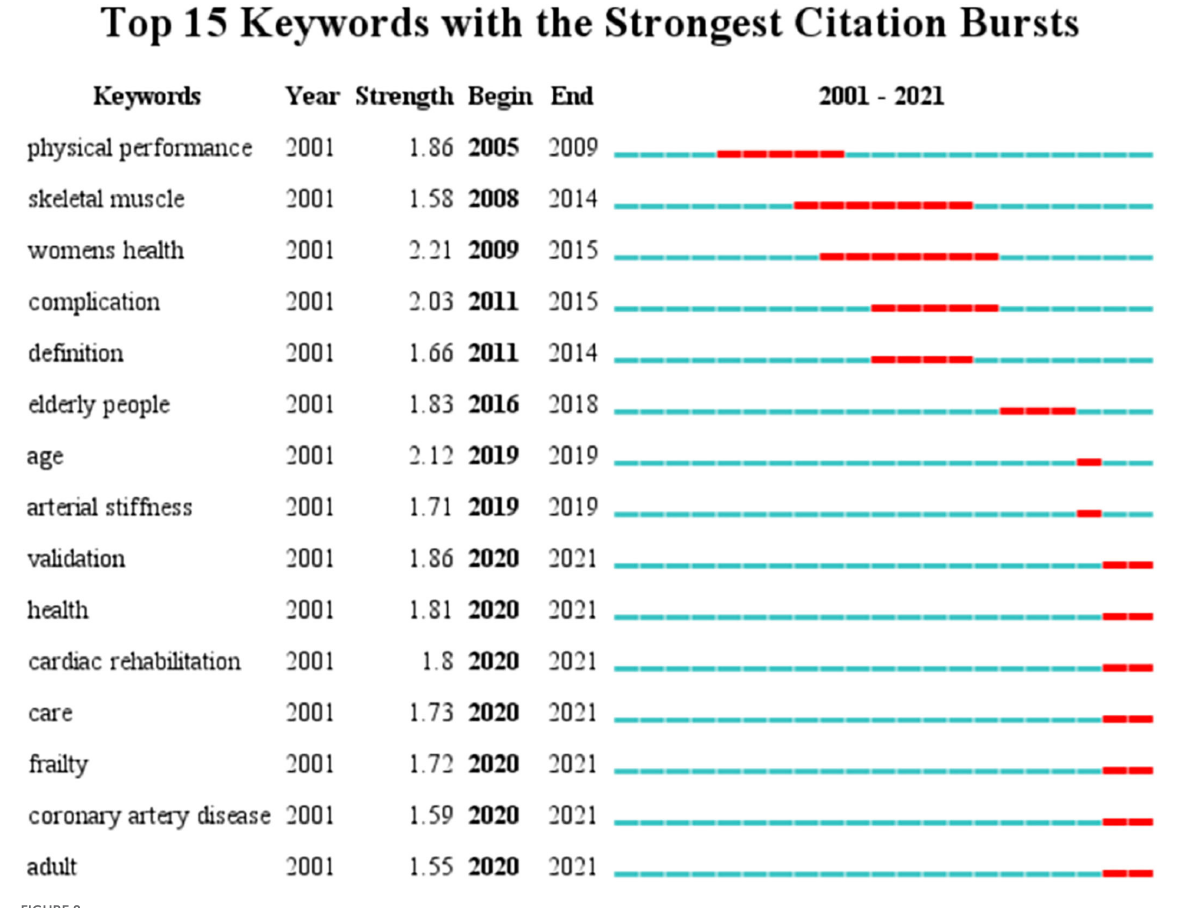
FIGURE8 Top 15 keywords of bursts related to CVD with frailty from 2000 to